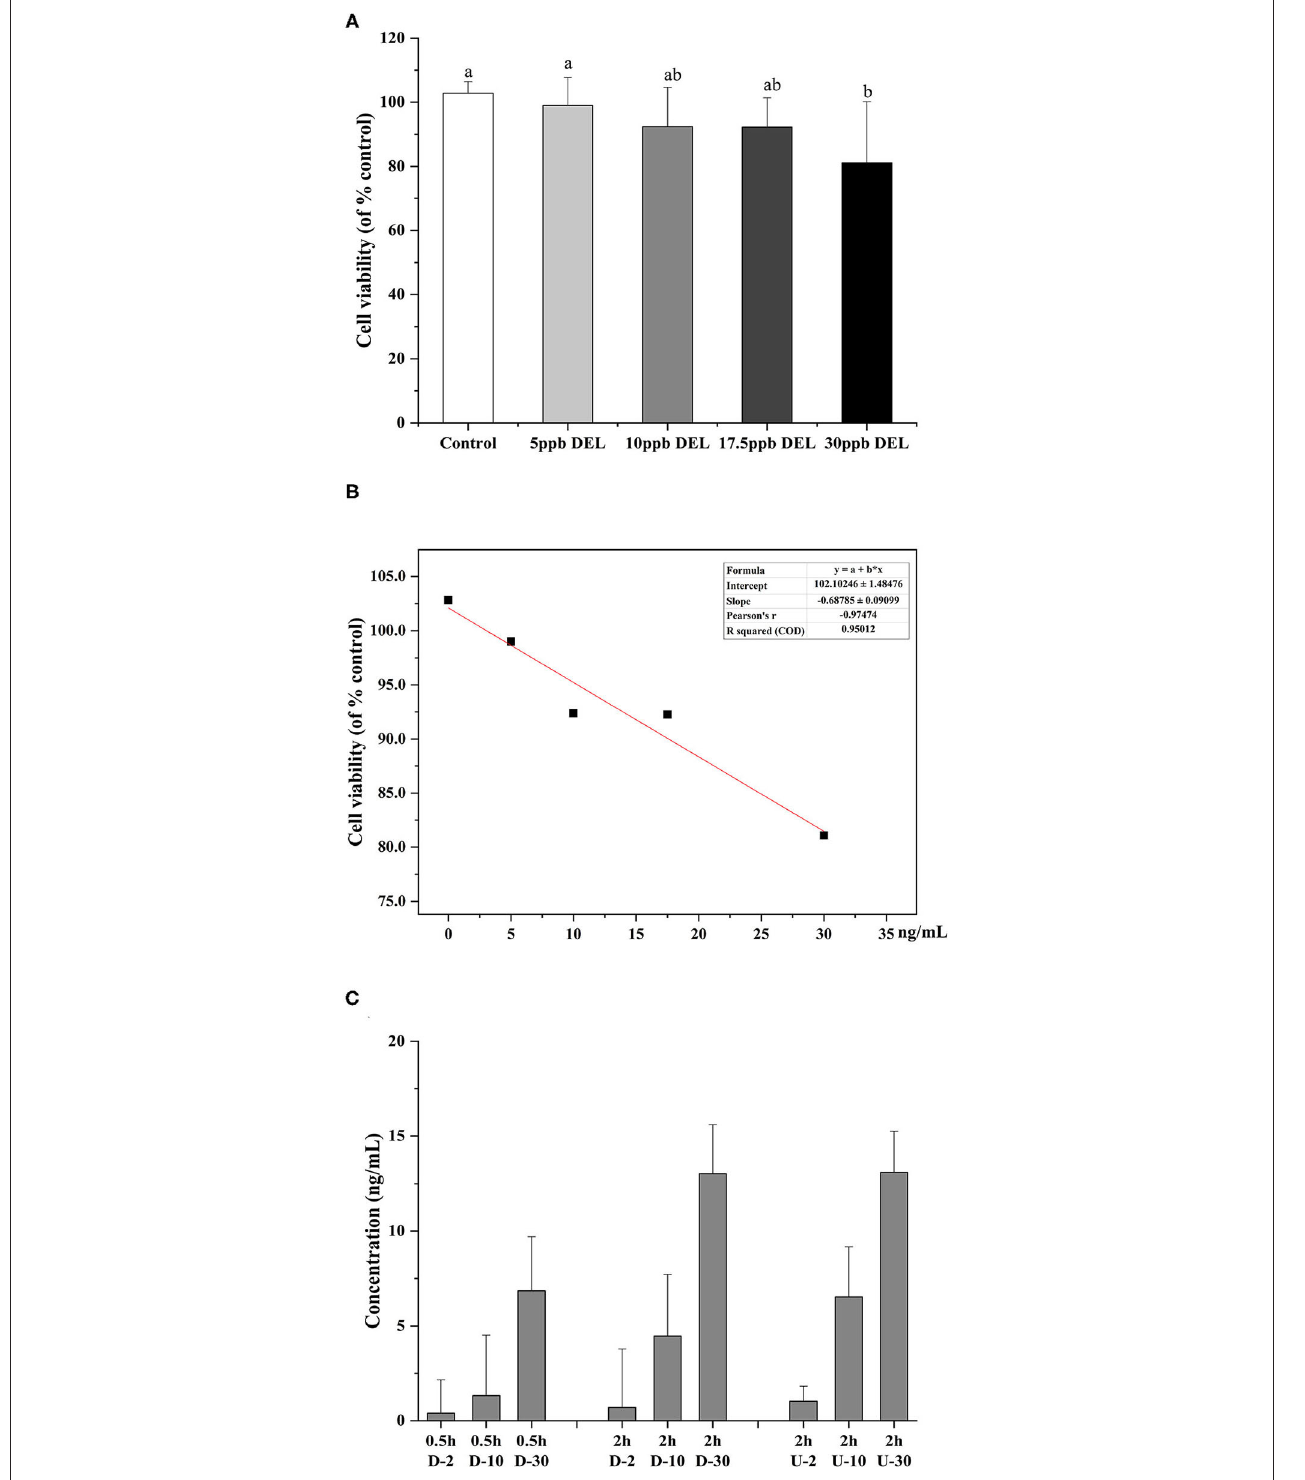
FIGURE 7 | Toxicity of DEL on the viability of NCM460 cells and transport efficiency. (A) Effect of DEL on the viability of NCM460 cells. The cell viability was significantly decreased after treatment with 30mM DEL for 24h. The data are expressed as the means ± SD ( n = 9). Values with different letters are significantly different ( p < 0.05). (B) Linear curve of cell viability (% of control) with DEL concentration. (C) Transport of DEL across NCM460 cell monolayers. The letter D represents the lower chamber of the Transwell, and the letter U represents the upper chamber of the Transwell. The concentration in the lower chamber shown in the figure is 3 times the actual